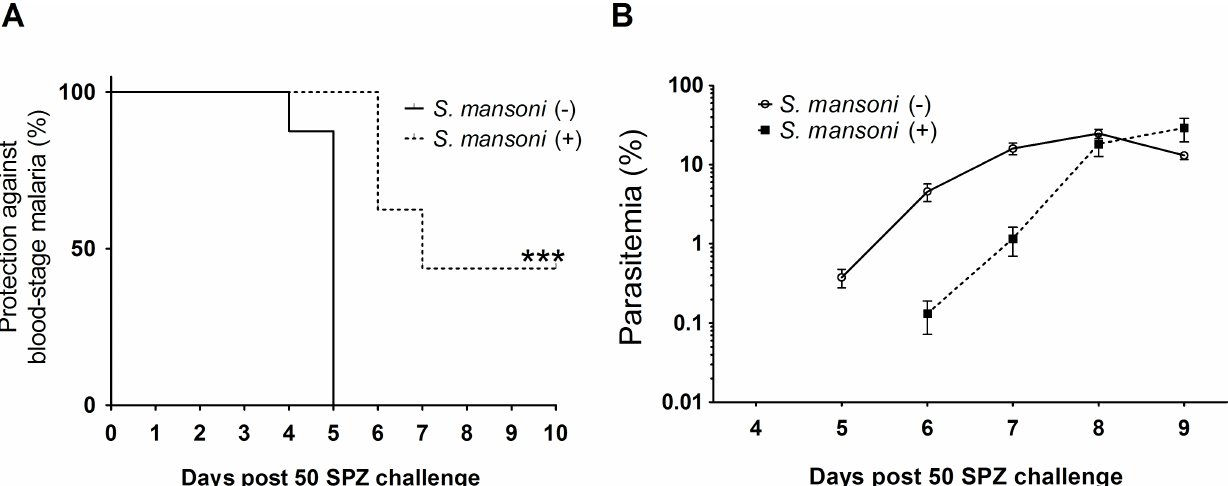
Fig 6. Malaria outcomes with low dose SPZ challenge. Female BALB/c mice (N = 16) infected with 50 Schistosoma mansoni -cercariae 10 weeks previously were challenged with 50 sporozoites of Plasmodium yoelii along with S . mansoni -non-infected controls. (A) The percentage of mice that did not develop blood stage infection following inoculation of low does SPZ. Data were statistically examined using the log-rank test. (cid:3)(cid:3)(cid:3) P < 0.001, x2 = 29.8, df = 1. (B) Parasitaemia. Mean parasitaemia in S . mansoni infected group was calculated only among blood stage malaria positive mice.